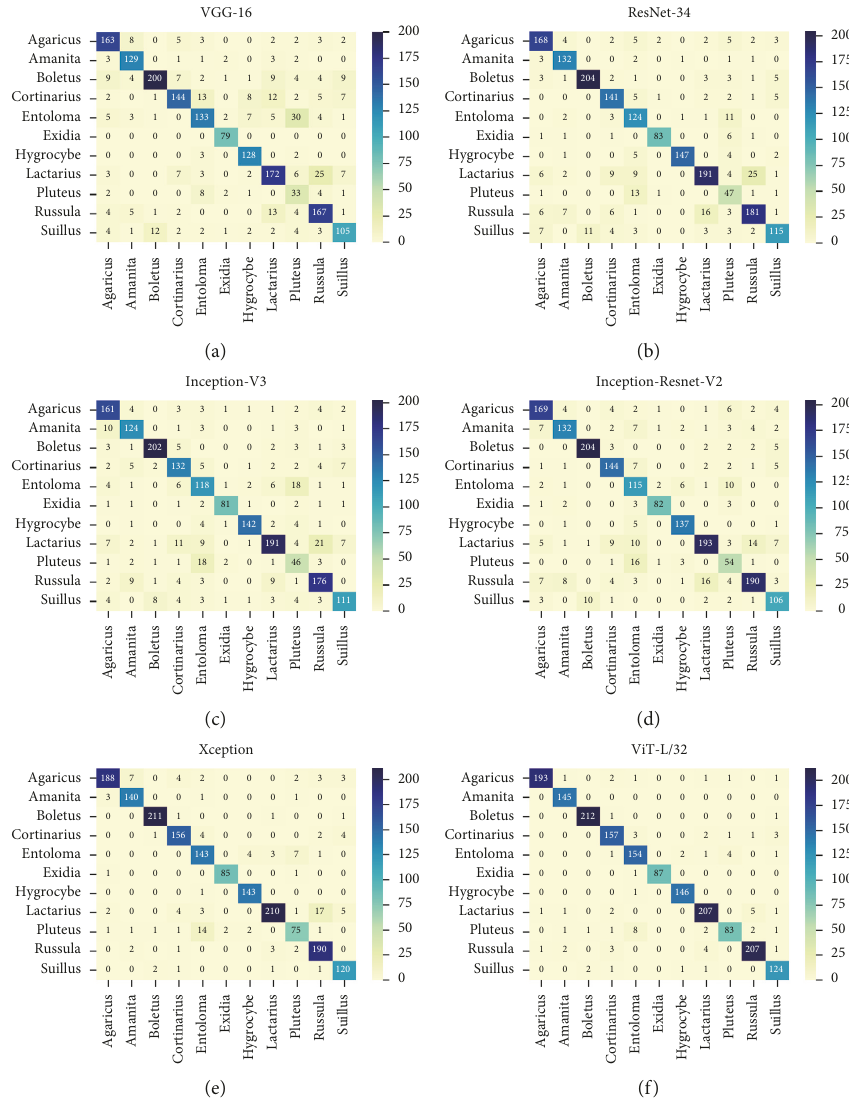
Figure 4: Confusion matrix of the classification results of all models: (a) VGG-16, (b) ResNet-34, (c) Inception-V3, (d) Inception-ResNet- V2, (e) Xception, (f)